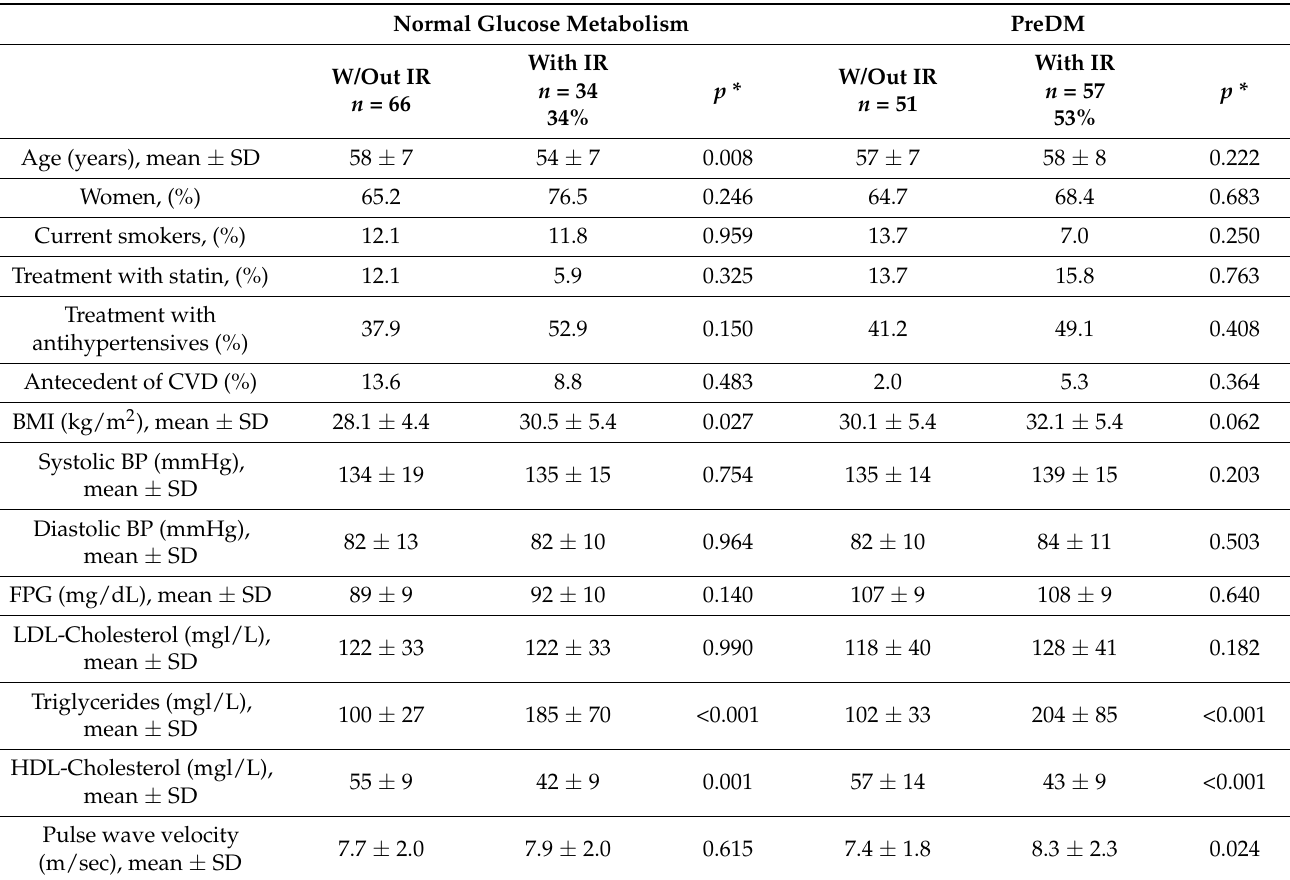
Table 2. Population according to OGTT and Insulin resistance (measured by TG/HDL-c